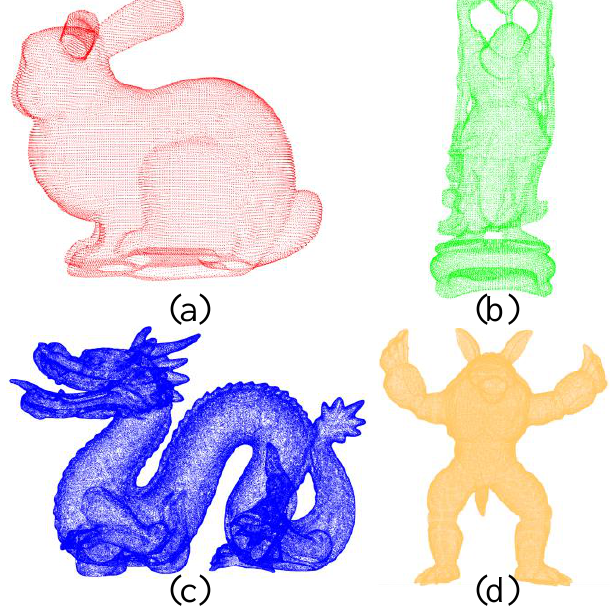
Figure 4. The Stanford Models used in this paper. ( a ) Stanford Bunny; ( b ) Happy Buddha; ( c ) Dragon; ( d ) Armadillo.